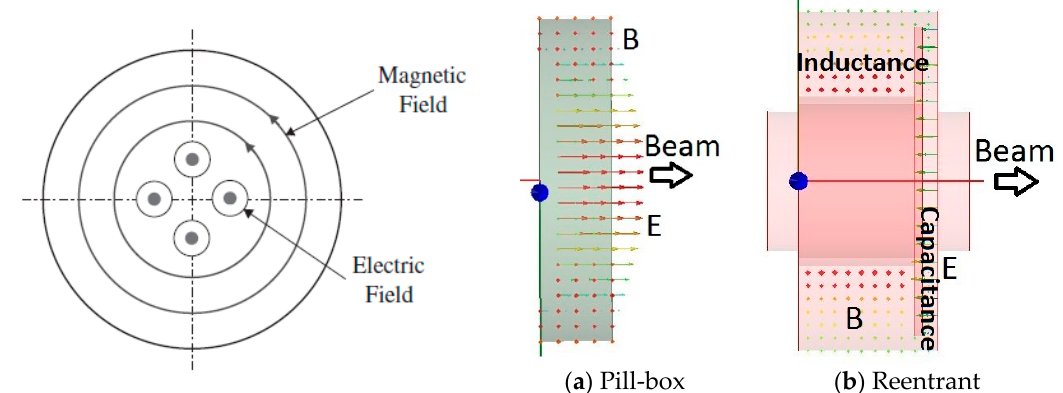
Figure 1. The fields of the monopole mode i.e., the fundamental mode when the beam points out of the page. The amplitude of the monopole mode is proportional to the bunch charge [15]. ( a ) is the field configuration in a pill-box cavity, and ( b ) is the field configuration in a reentrant cavity where the induced E and B field vectors are separated.